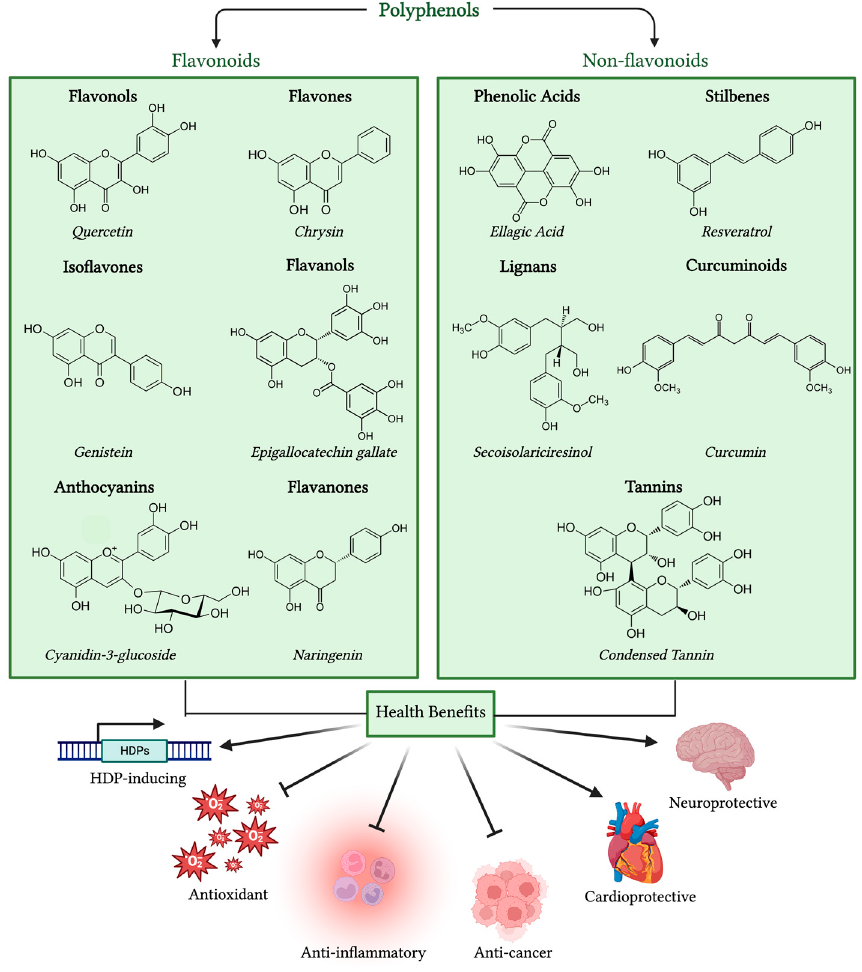
Figure 2. Classifications and health benefits of polyphenols. One representative compound is shown in each category for illustrative purposes.